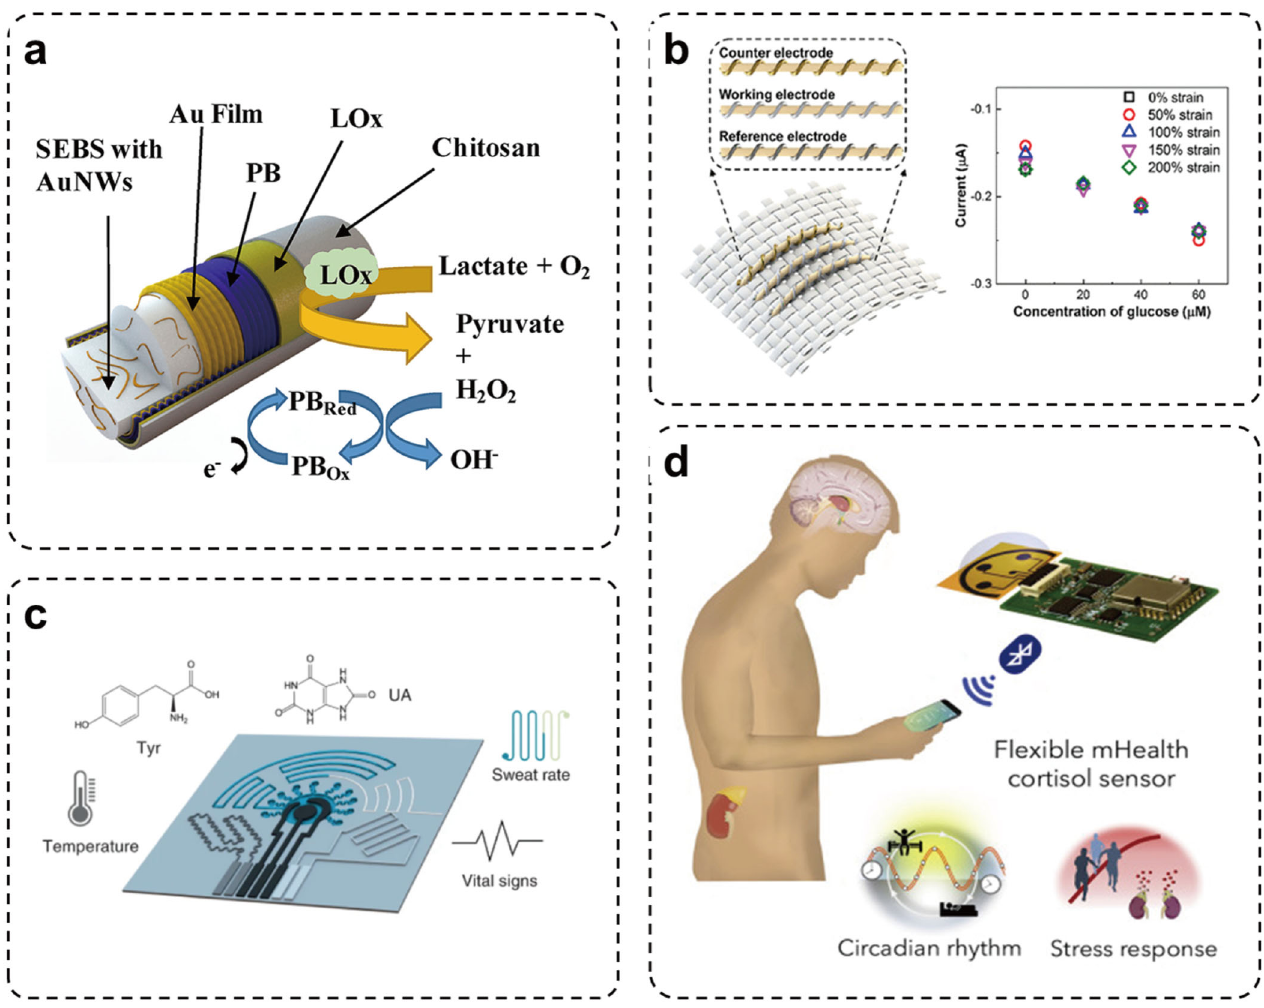
Fig. 5 Examples of metabolite sensors. a A real-time noninvasive lactate sensor for human perspiration. Ref. 82 , Copyright 2021, Talanta. b An elastic gold fi ber-based three-electrode electrochemical platform that can meet the criteria of wearable textile glucose biosensing. Ref. 85 , Copyright 2019, Analytical Chemistry. c Multifunction sensor: ultrasensitive sweat UA and Tyr detection, sweat rate estimation, temperature sensing and vital-signs monitoring. Ref. 86 , Copyright 2020, Nature Biotechnology. d An integrated wireless graphene-based sweat stress sensing system for dynamic and noninvasive stress hormone analysis. Ref. 89 , Copyright 2020,